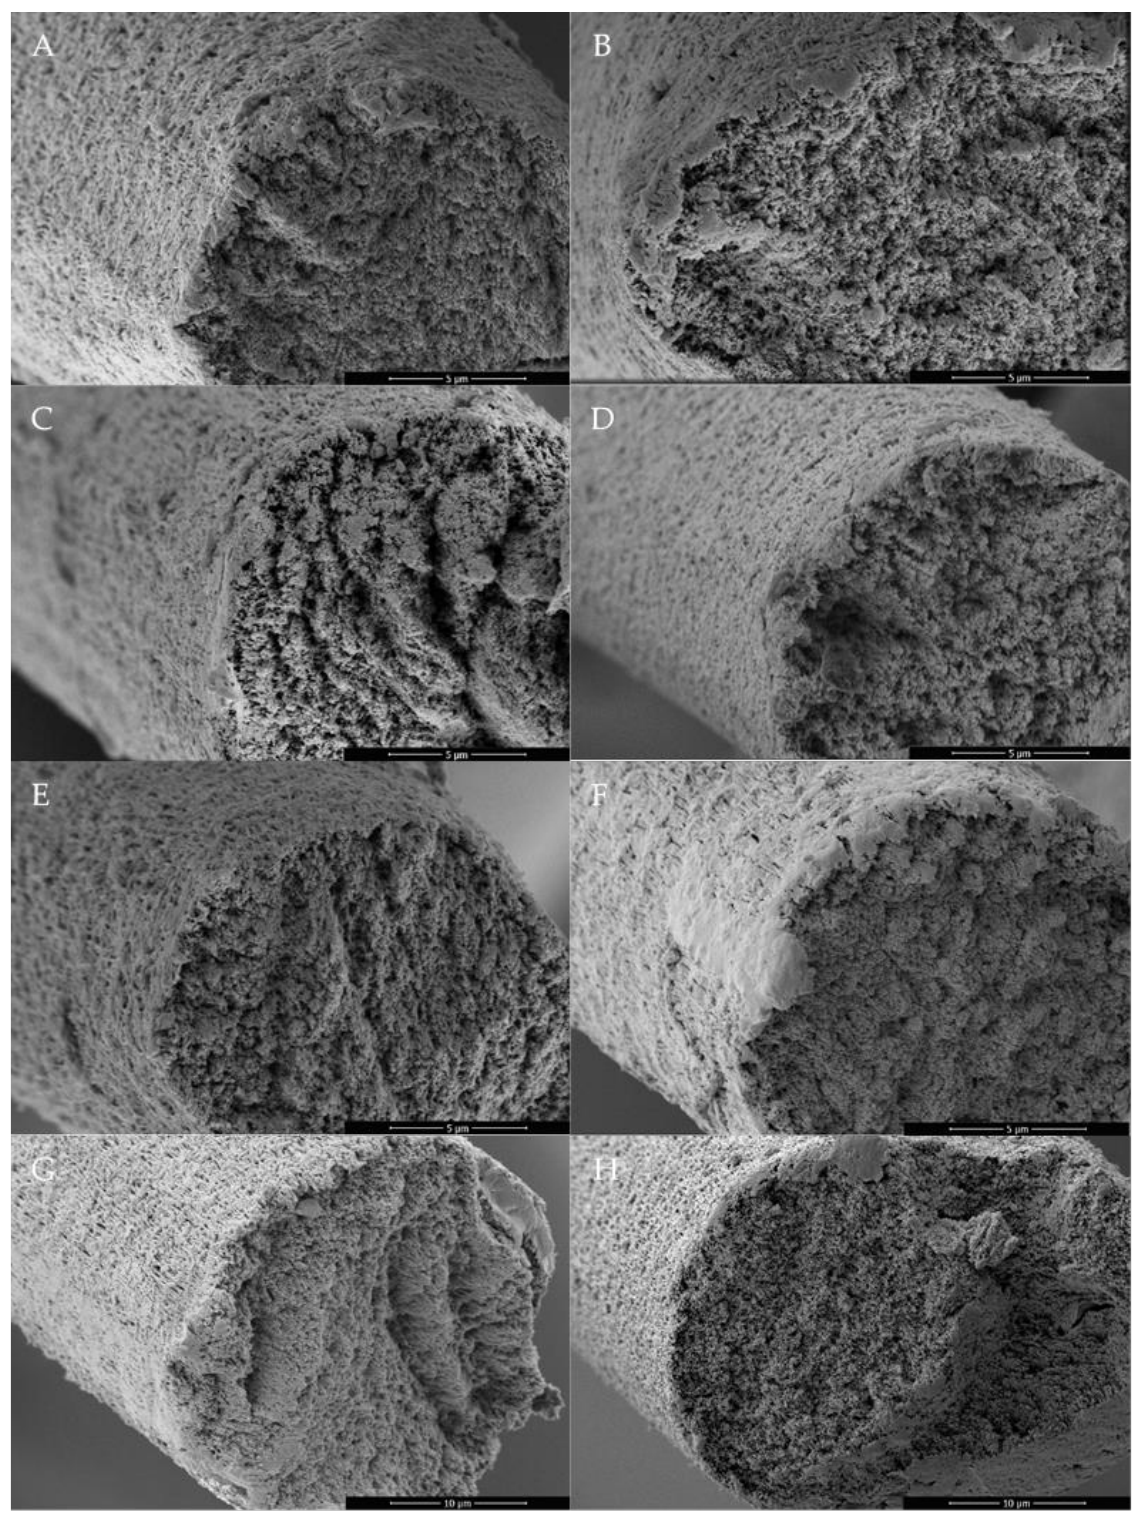
Figure 3. SEM images of the cross-section of the developed porous PAN/NC fibers after 50% stretch- ing (left): ( A ) 0 wt.% NC, ( C ) 0.1 wt.% NC 1, ( E ) 0.4 wt.% NC 4 and ( G ) 0.8 wt.% NC; 100% stretching (right): ( B ) 0 wt.% NC, ( D ) 0.1 wt.% NC 1, ( F ) 0.4 wt.% NC 4 and ( H ) 0.8 wt.% NC.